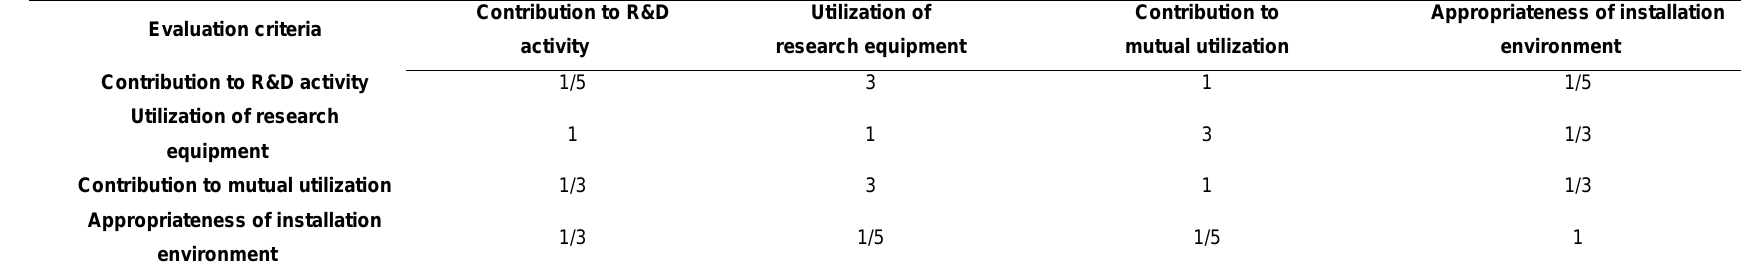
Table 6. Relative importance of the evaluation criteria